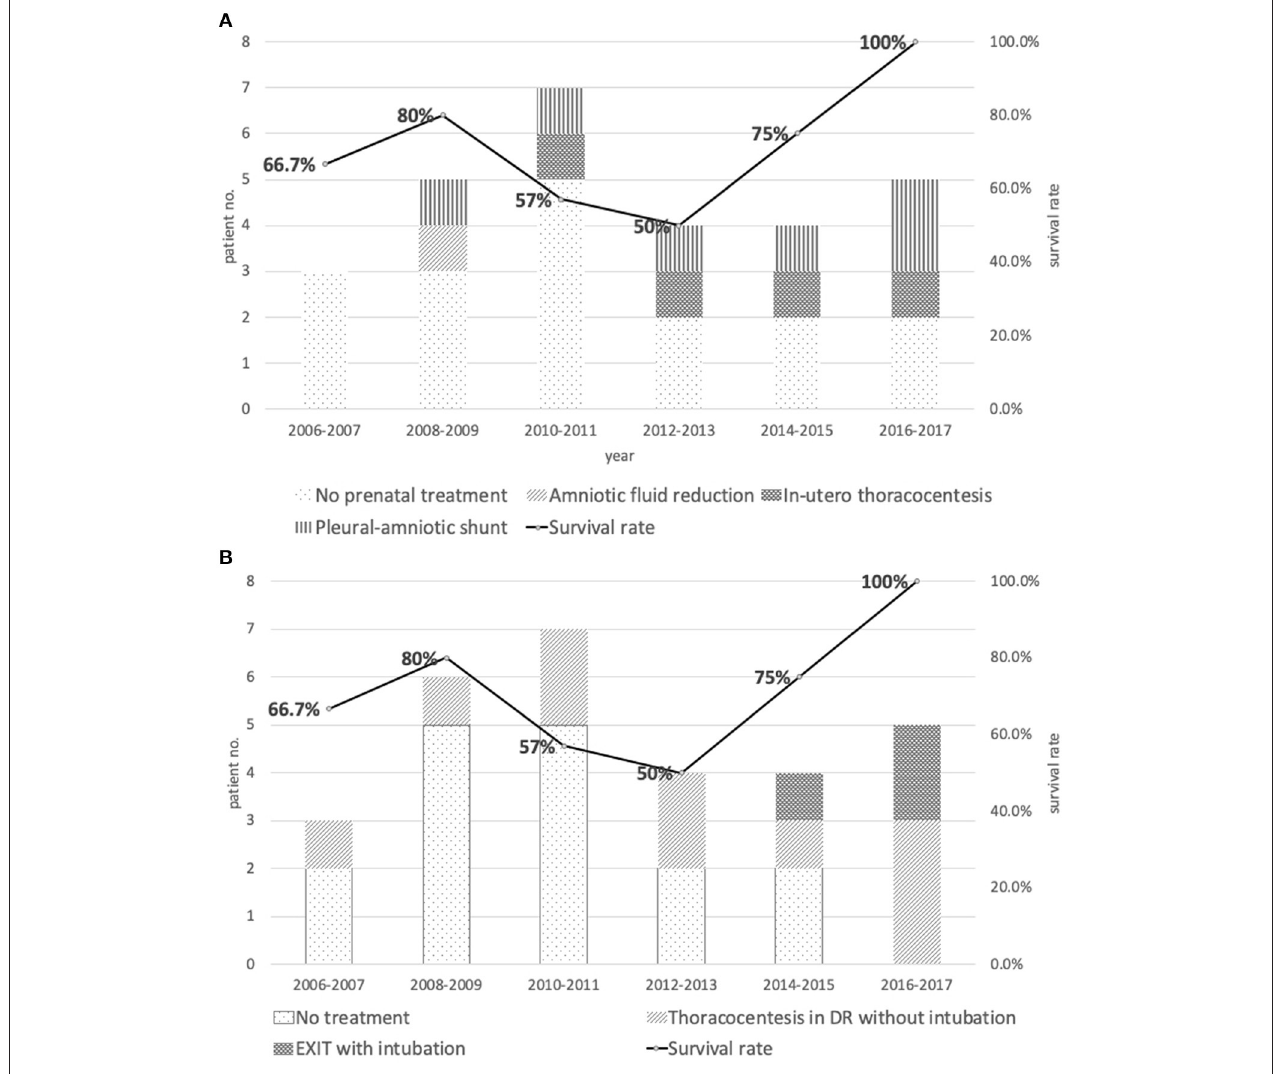
FIGURE 2 | (A) Distribution and types of prenatal treatments vs. survival rate between 2006 and 2017. (B) Distribution and types of intrapartum management vs. survival rate between 2006 and